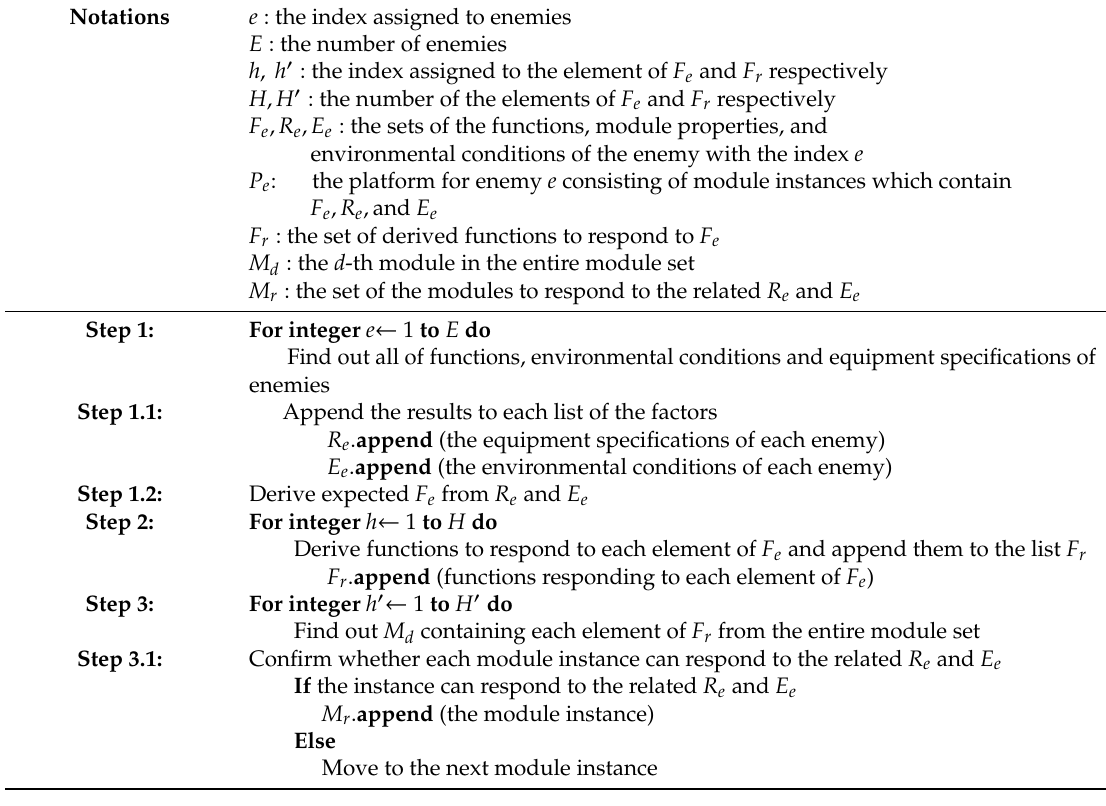
Table A1. Process to analyze contextual